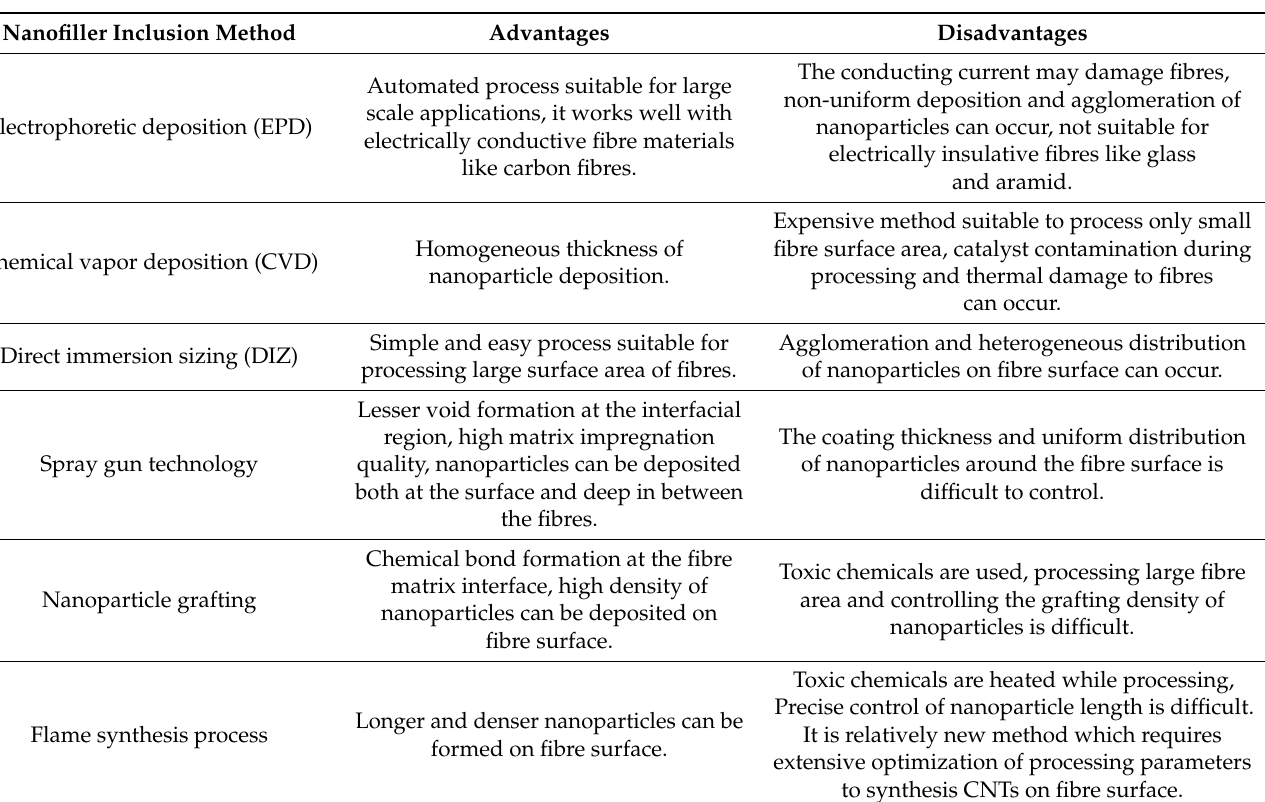
Table 2. Advantages and disadvantages of various nanoparticle inclusion